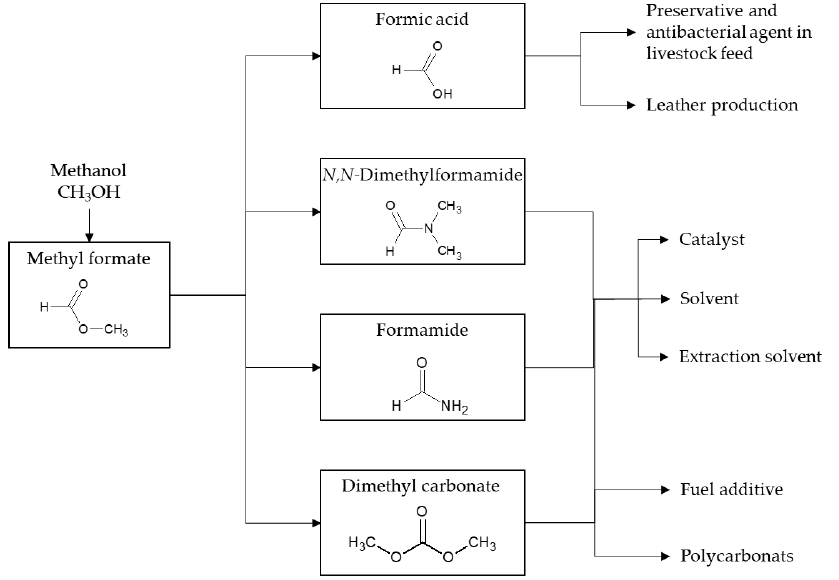
Figure 1. Selection of important products derivable from MF as a C 1 building block and their application [5].